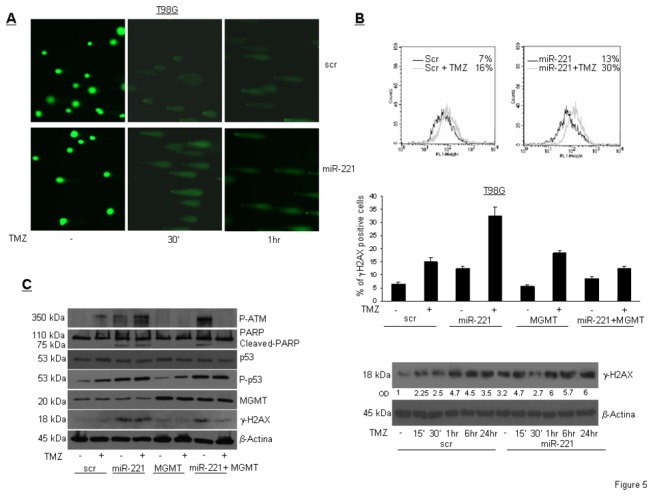
miR-221 promotes DNA damage.(A) Alkaline comet assay of T98G cells transfected with miR-221 and treated with TMZ for the indicated times. (B) Analysis of γH2AX in T98G cells transfected with scrambled control miR or miR-221, treated with TMZ in the presence or in the absence of MGMT cDNA, by immunocytofluorescence (upper and medium panel) or by Western blot (lower panel). (C) Western blot analysis of the indicated proteins upon transfection of T98G cells with miR-221 and MGMT cDNA and TMZ treatment for 24 hrs.